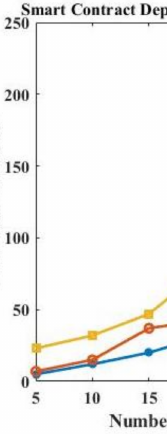
Figure 8. Contract deployment analysis.